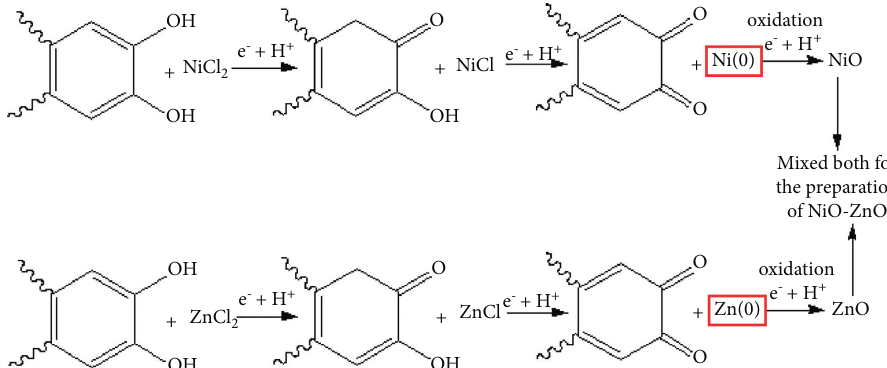
Figure 2: Proposed mechanism for the green synthesis of NiO-ZnO